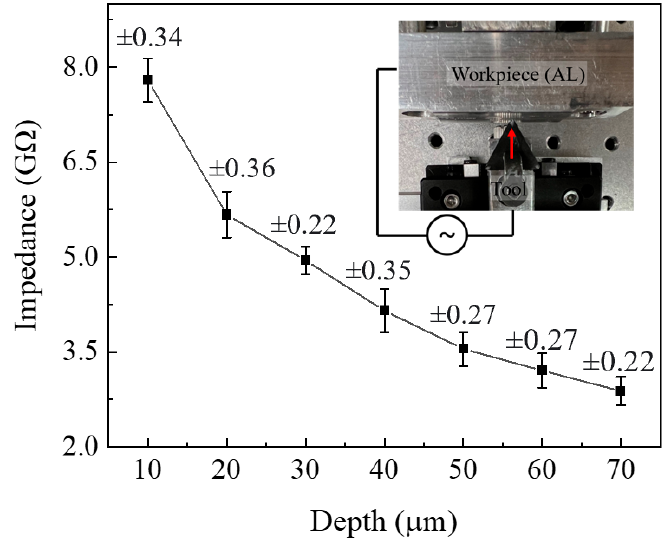
Figure 10. Impedance measurement under varying depth of contact.